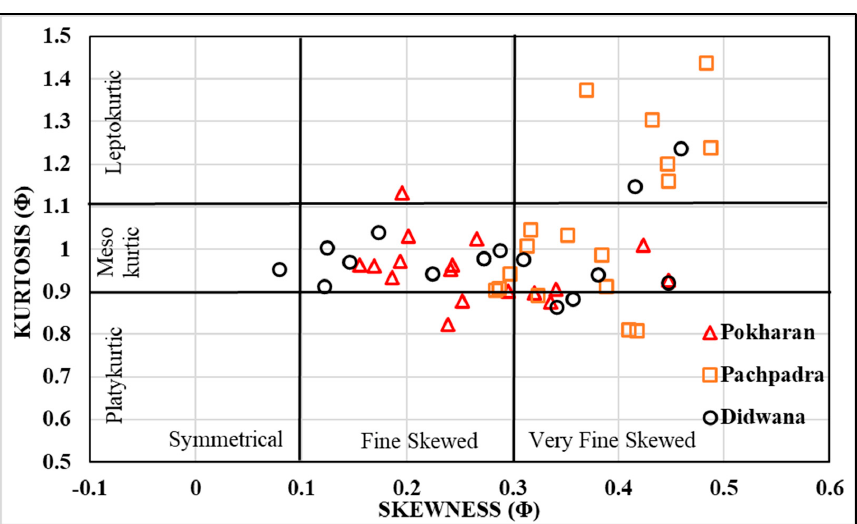
Figure 5. Bivariat plot between skewness and kurtosis.